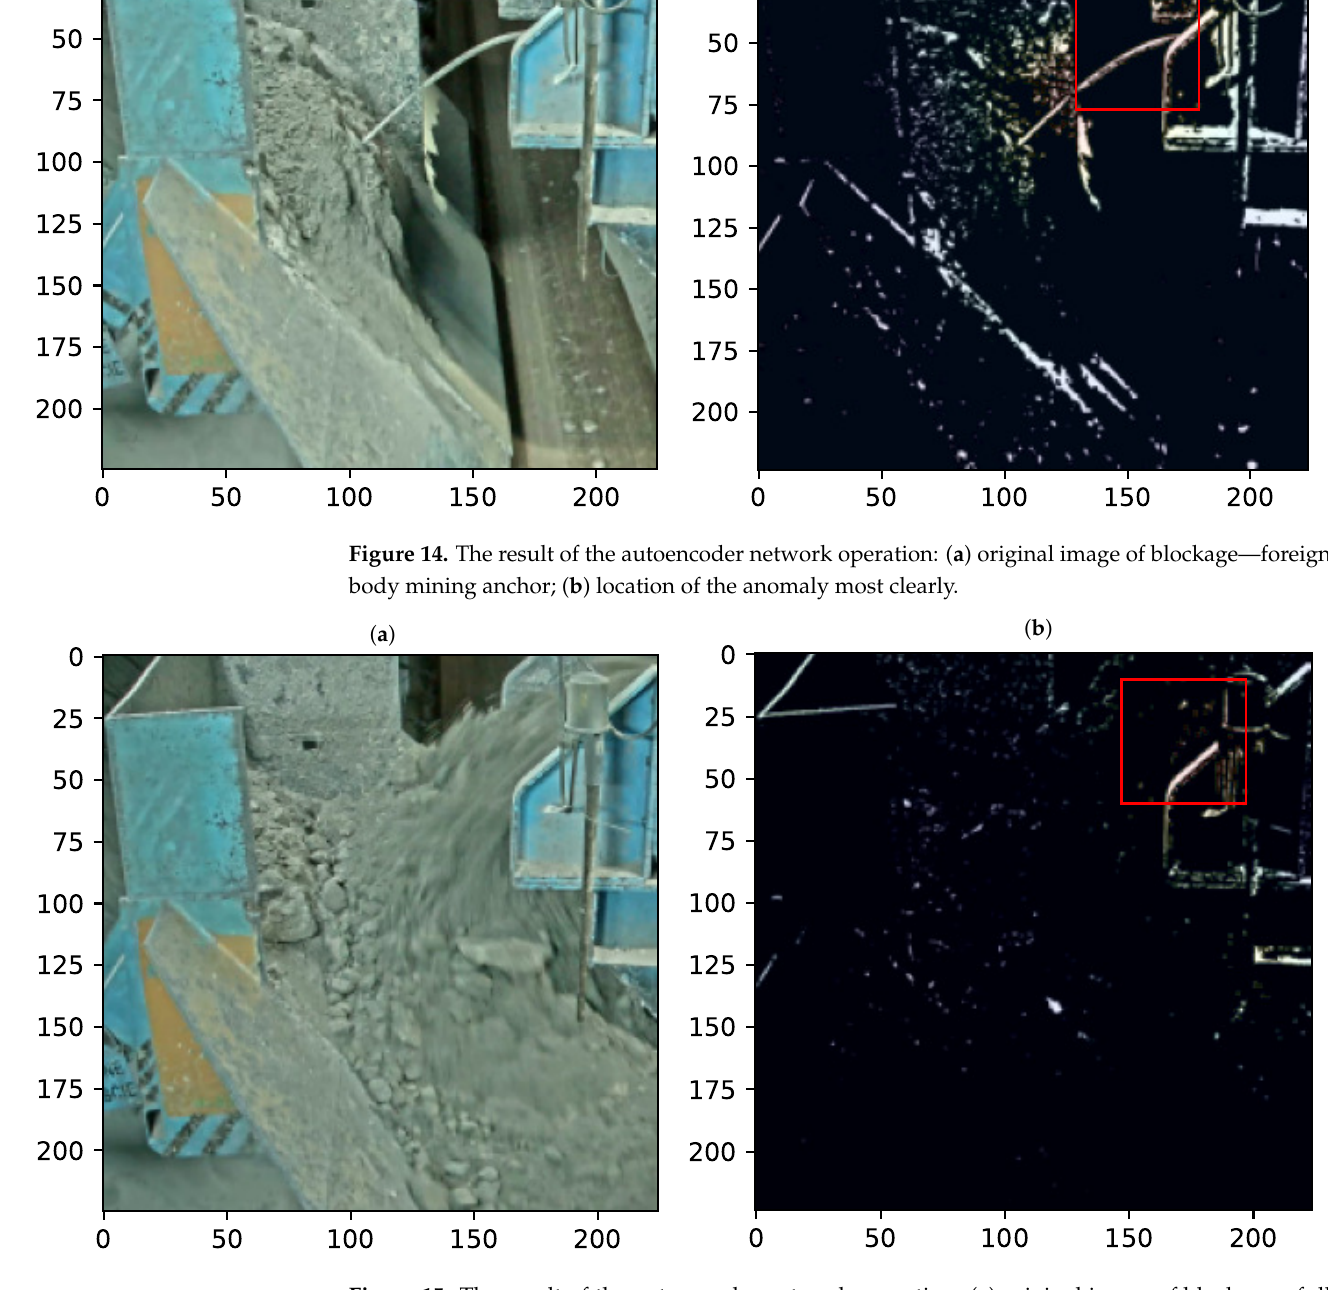
Figure 15. The result of the autoencoder network operation: ( a ) original image of blockage—full blockage; ( b ) location of the anomaly most